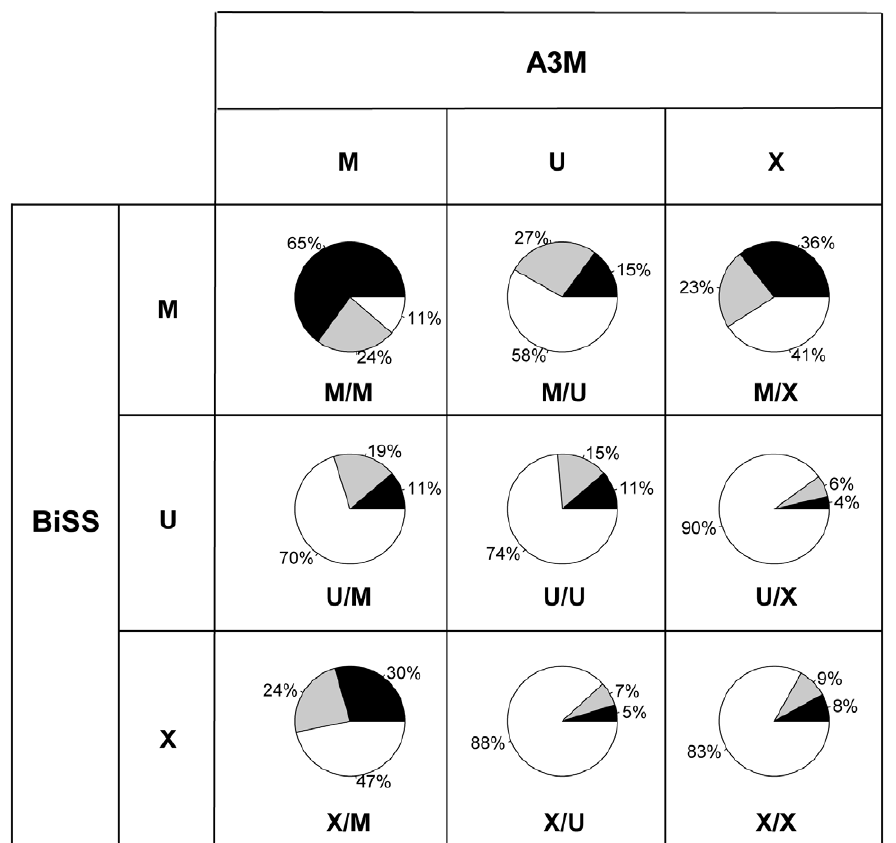
Figure 2. Methylation status according to BiSS and A3M split into distribution of cytosine sequence context. M, methylated; U, unmethylated; X, not determined. Percentages refer to the total numbers in Table 2.